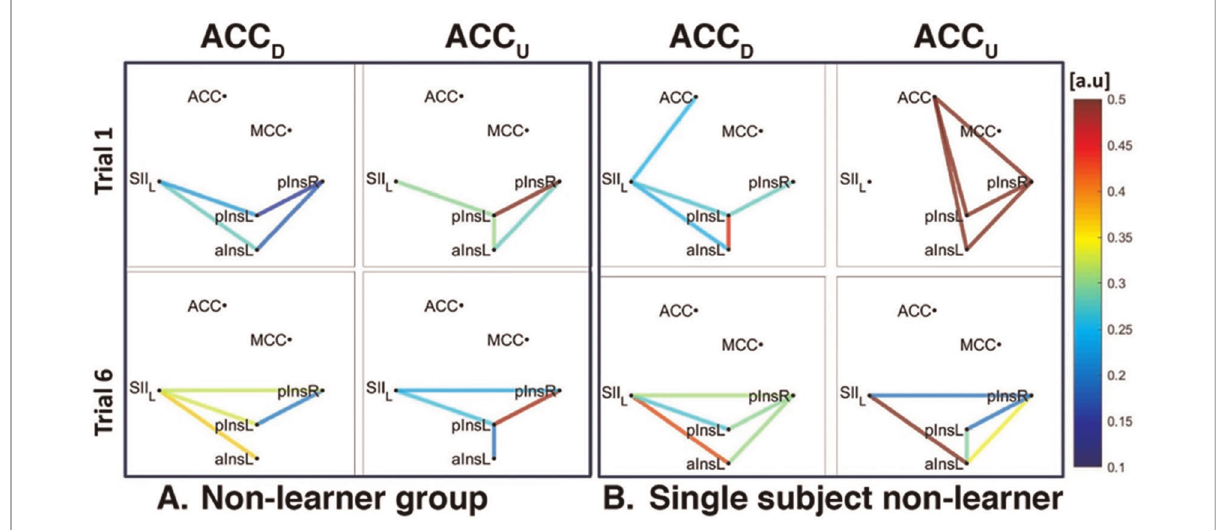
FIGURE 6 Connectivity strengths identi fi ed using the Coherence analysis for the ACC condition (ACC D , ACC U ) in the non-Learner group ( A ) and for a representative non-Learner ( B ) in the fi rst trial (Trial 1, top) and in the last trial (Trial 6, bottom). The colors from blue to red indicate weak to strong connection strength respectively and are expressed in arbitrary units (a.u).